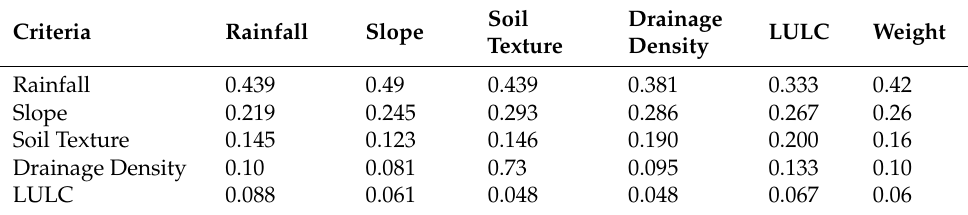
Table 5. Pairwise comparison